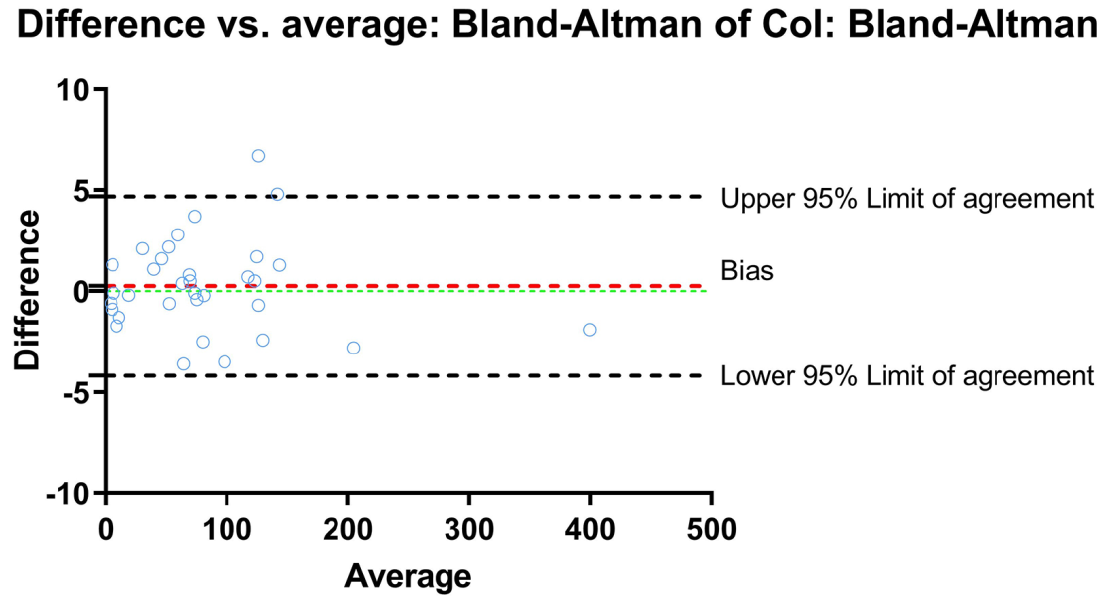
Figure 8. Bland and Altman plot for data measured over 2-week intervals concerning cephalo- metric